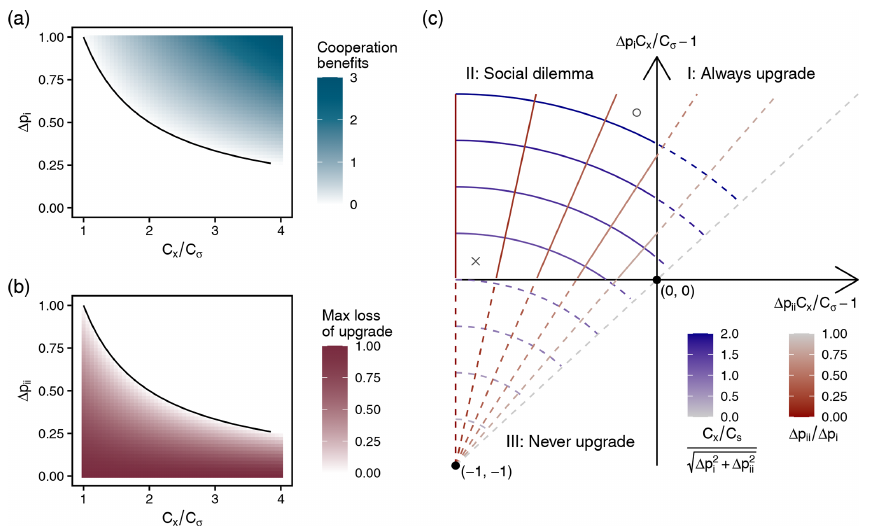
Figure 5. Social dilemmas as a result of individual and collective upgrades. (a) The benefits of cooperation, given as (cid:49)p i C x /C σ − 1. (b) The maximum loss of upgrading, given as the expected decrease in utility for a single house to upgrade in the absence of cooperation (1 − (cid:49)p ii C x /C σ ). (c) Benefits of cooperation versus the (inverse) maximum loss of upgrading, with a social dilemma occurring in quadrant II. Blue contours indicate constant cost ratios ( C x /C s ), with higher cost ratios increasing the benefits of upgrading. Red contours indicate the ratio of (cid:49)p ii /(cid:49)p i , with lower values meaning that players receive little benefit from upgrading their own septic tank relative to all other players upgrading.